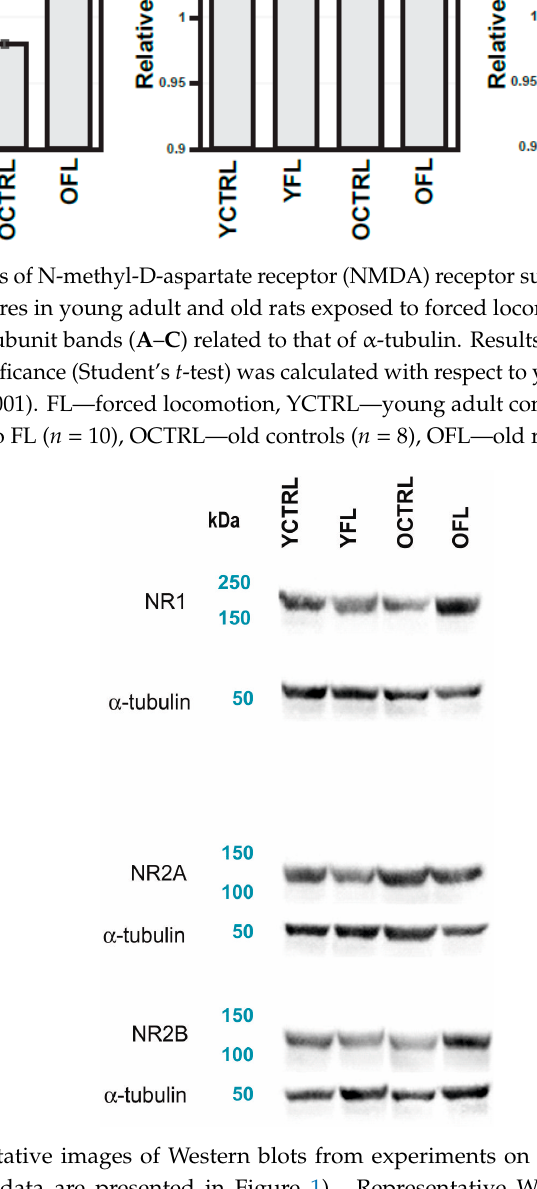
Figure 2. Representative images of Western blots from experiments on young adult and old rats exposed to FL (all data are presented in Figure 1). Representative Western blots showing the expression of NMDA receptor subunits, used for quantification of their changes in the frontal cortex. Anti-NMDA-NR1, anti-NMDA-NR2A and anti-NMDA-NR2B (all fromMerck) were used as primary antibodies. The loading control was incubated with an anti- α -tubulin antibody (Exbio). FL—forced locomotion, YCTRL—young adult control, YFL—young adult rat exposed to FL, OCTRL—old control, OFL—old rat exposed to FL.